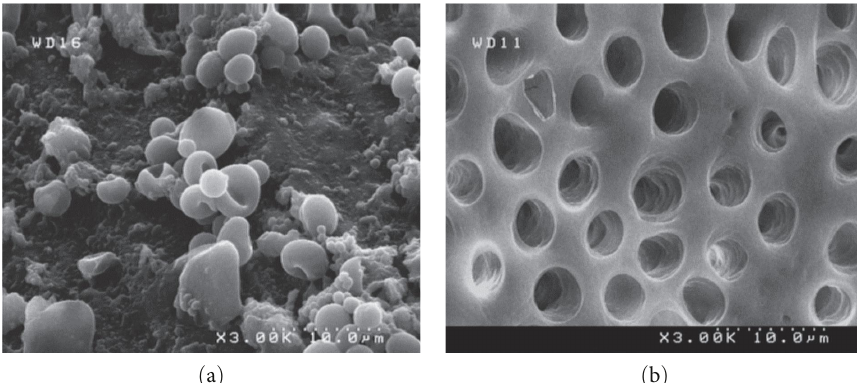
F IGURE 2: SEM micrographs: (a) specimen inoculated with E. faecalis ; (b) dentinal tubules after elimination of smear layer ( × 3,000 magni fi